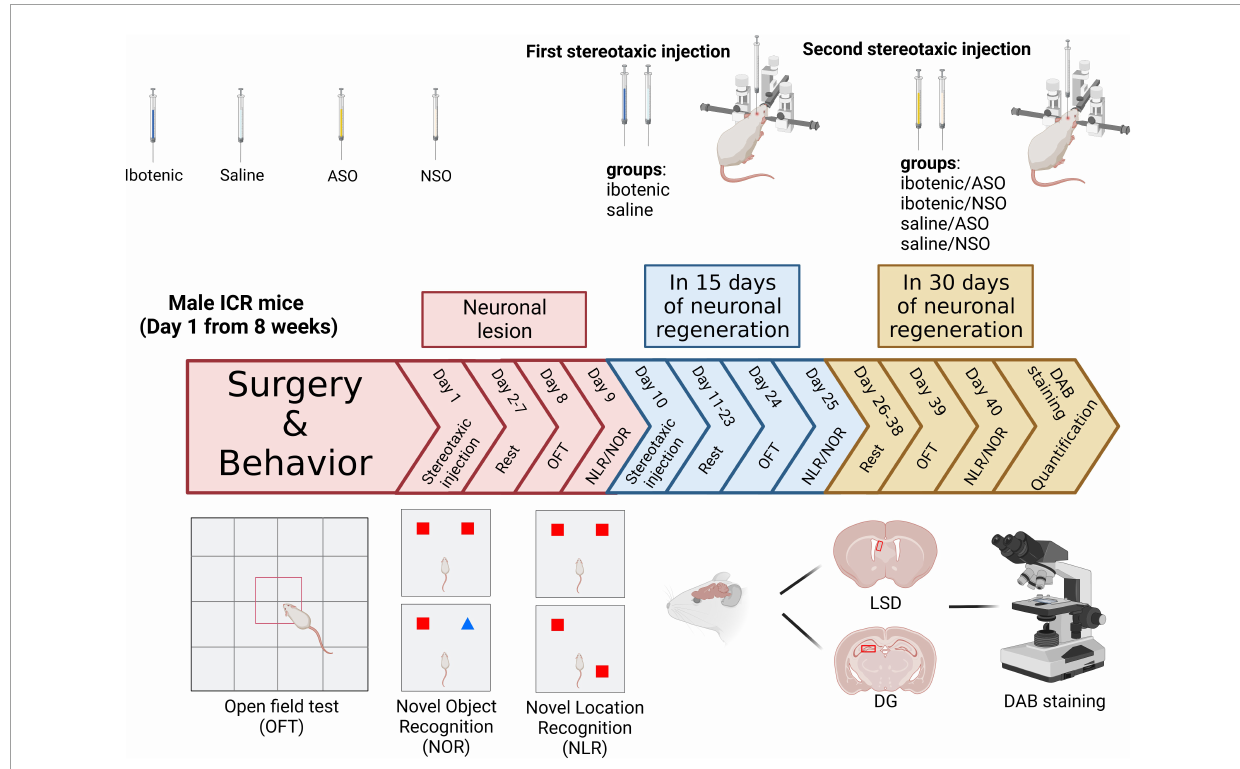
FIGURE1 Timeline of the study and experimental design. ASO, antisense oligonucleotide; NSO, nonsense oligonucleotide; OFT, open field test; NOR, novel object recognition; NLR, novel location recognition; LSD, the dorsal part of the lateral septal nucleus; DG, dentate gyrus; DAB staining, 3,3 (cid:48) -diaminobenzidine staining. Created with